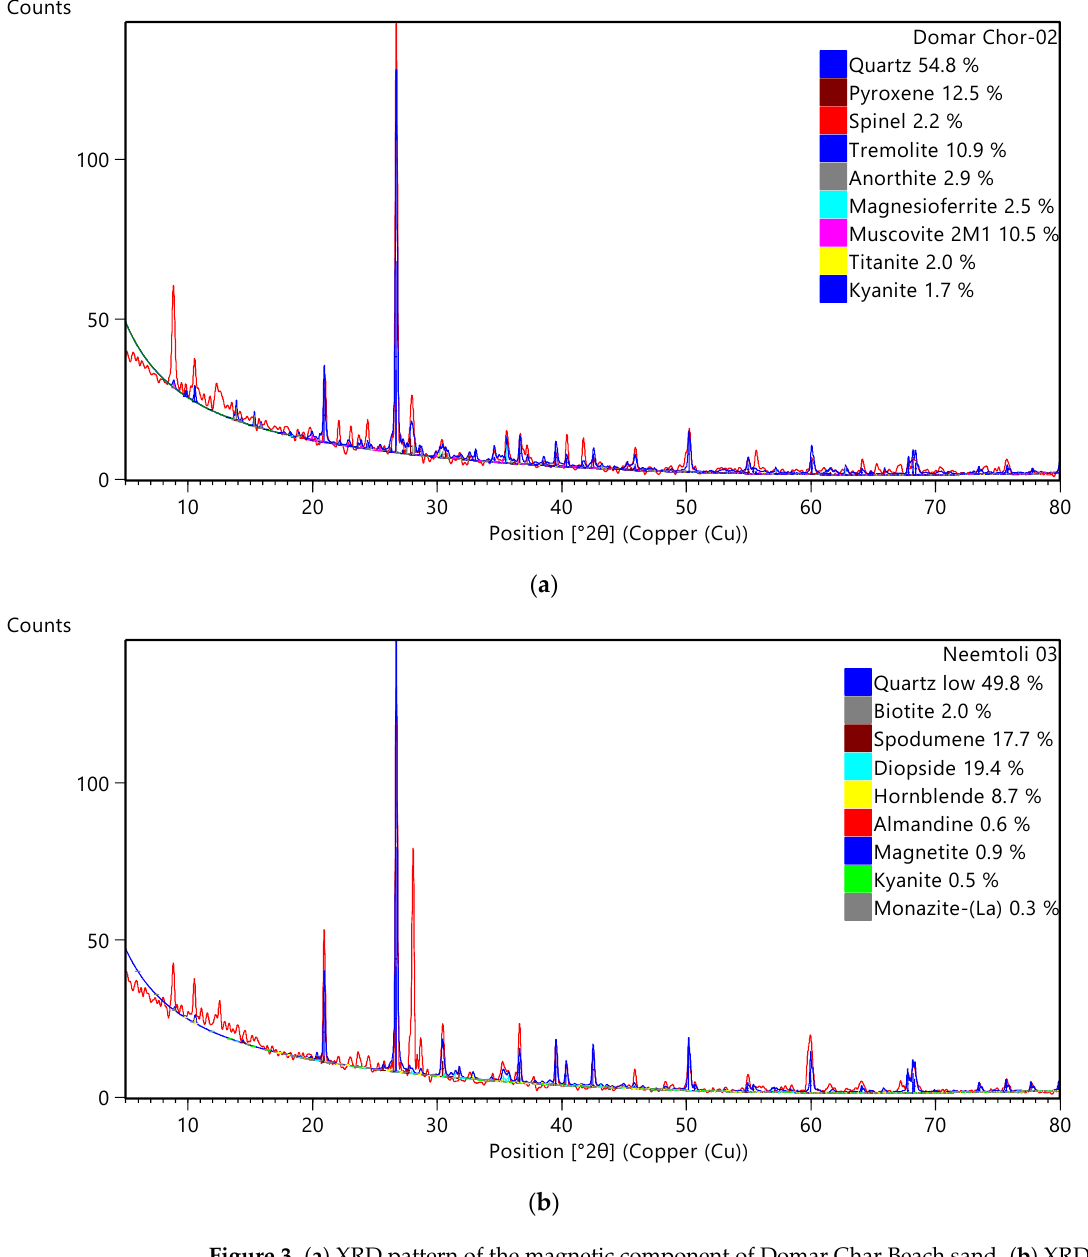
Figure 3. ( a ) XRD pattern of the magnetic component of Domar Char Beach sand. ( b ) XRD pattern of the magnetic component of Neemtoli Beach sand.